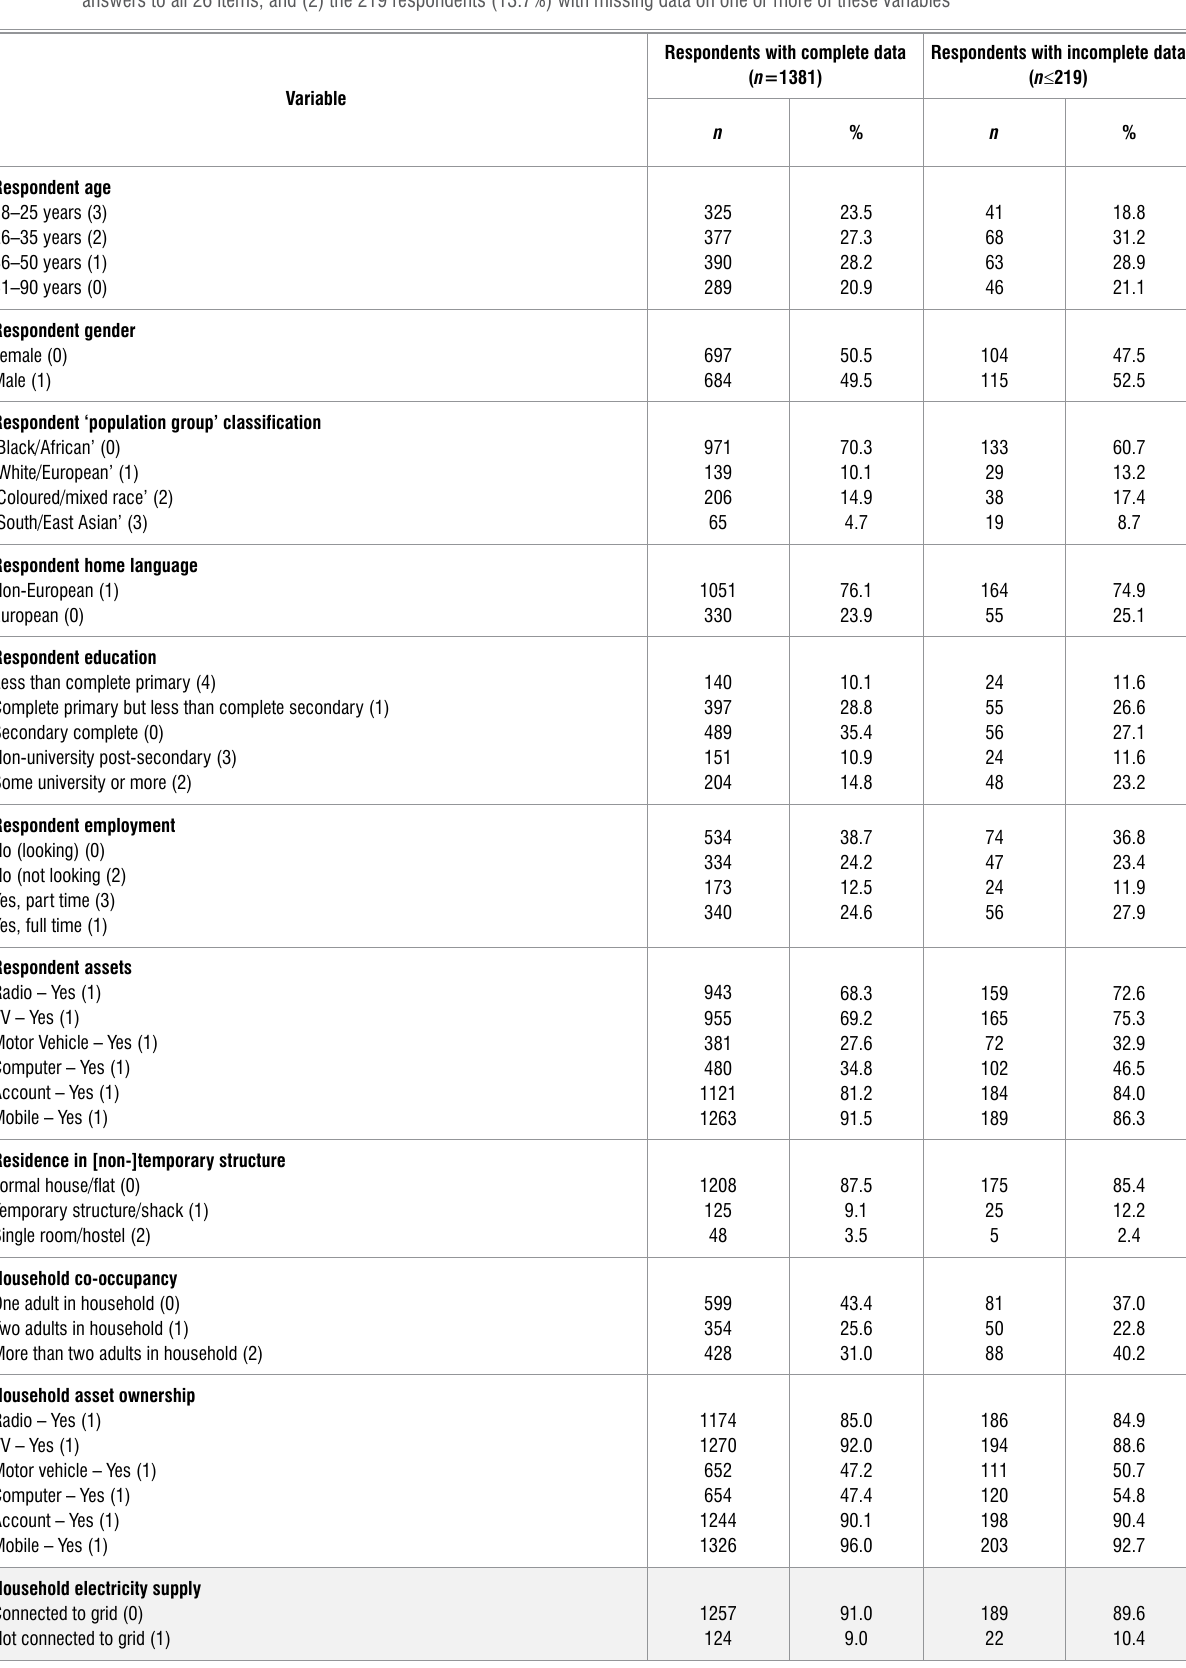
Table 1: The distribution of the 26 re-categorised items from the AB-R8 survey amongst: (1) the 1381 (86.3%) South African respondents who provided answers to all 26 items; and (2) the 219 respondents (13.7%) with missing data on one or more of these variables Respondents with complete data ( n Variable